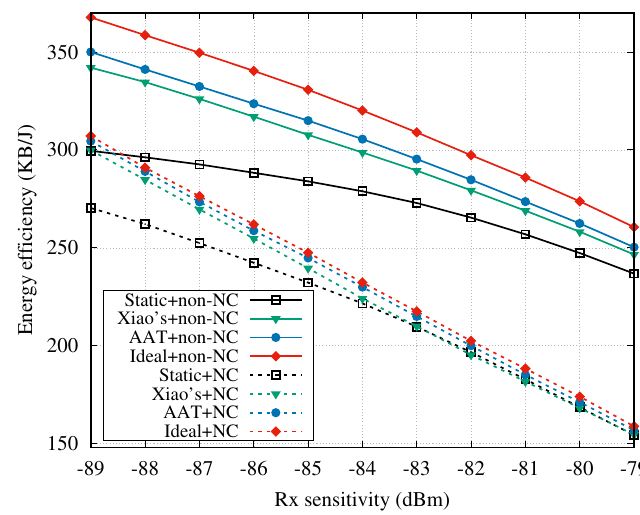
Figure 12. Energy efficiency vs. Rx sensitivity.